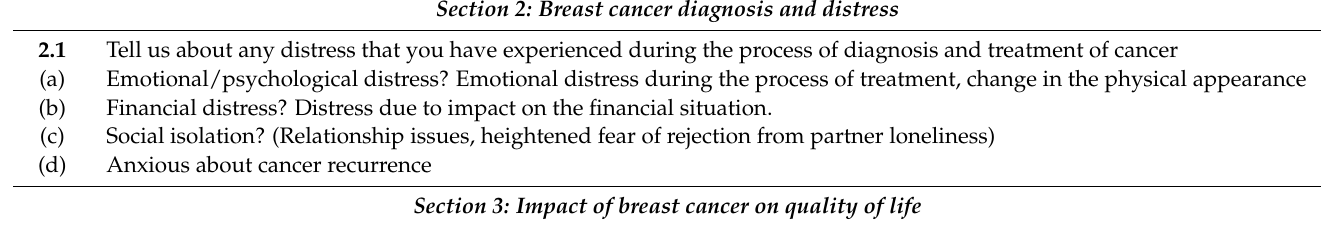
Section 3: Impact of breast cancer on quality of